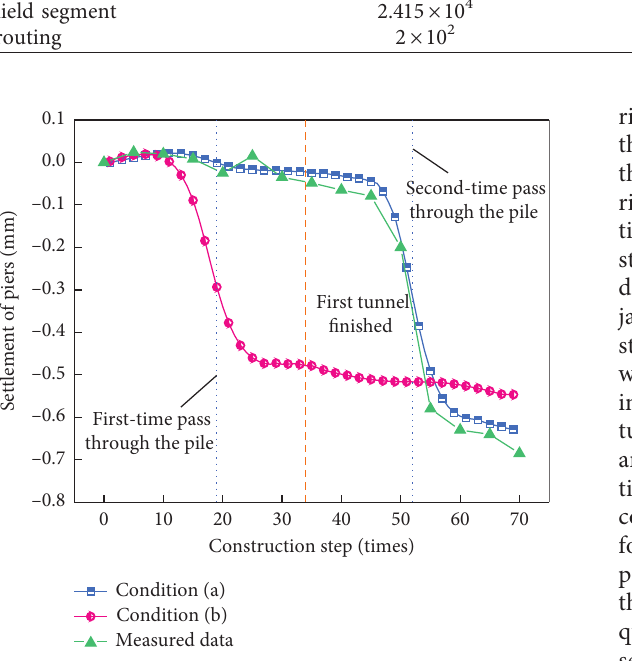
Figure 9: The settlement of viaduct pier